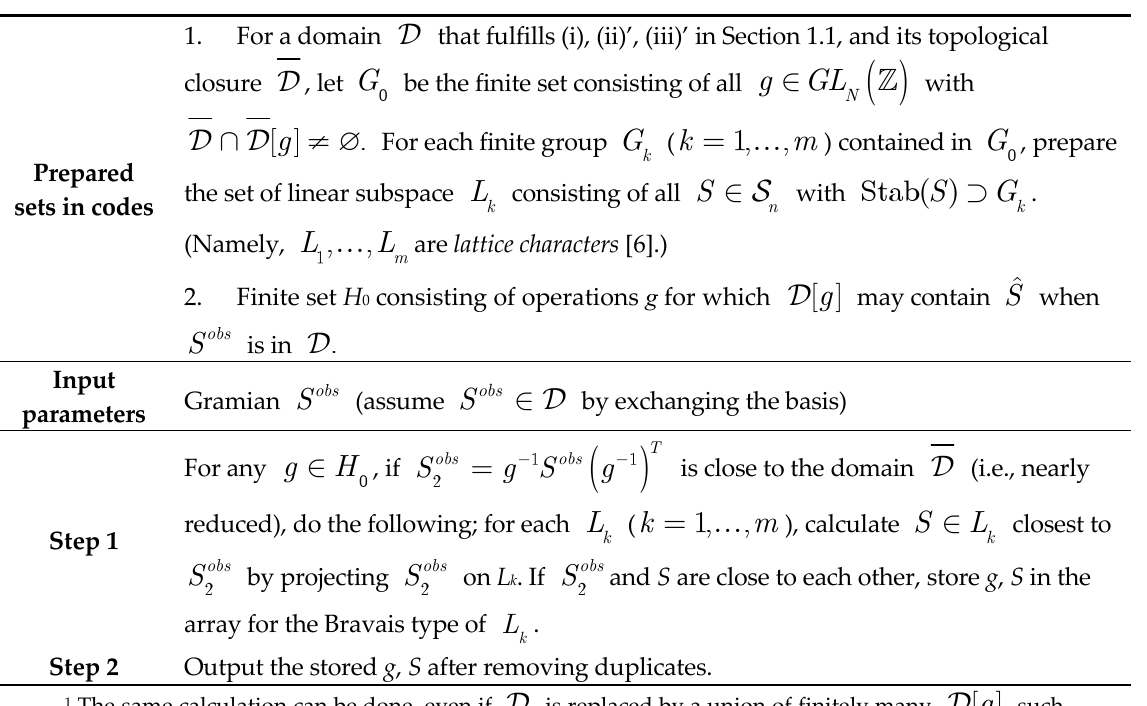
Table 1. Outline of error-stable Bravais lattice determination methods 1